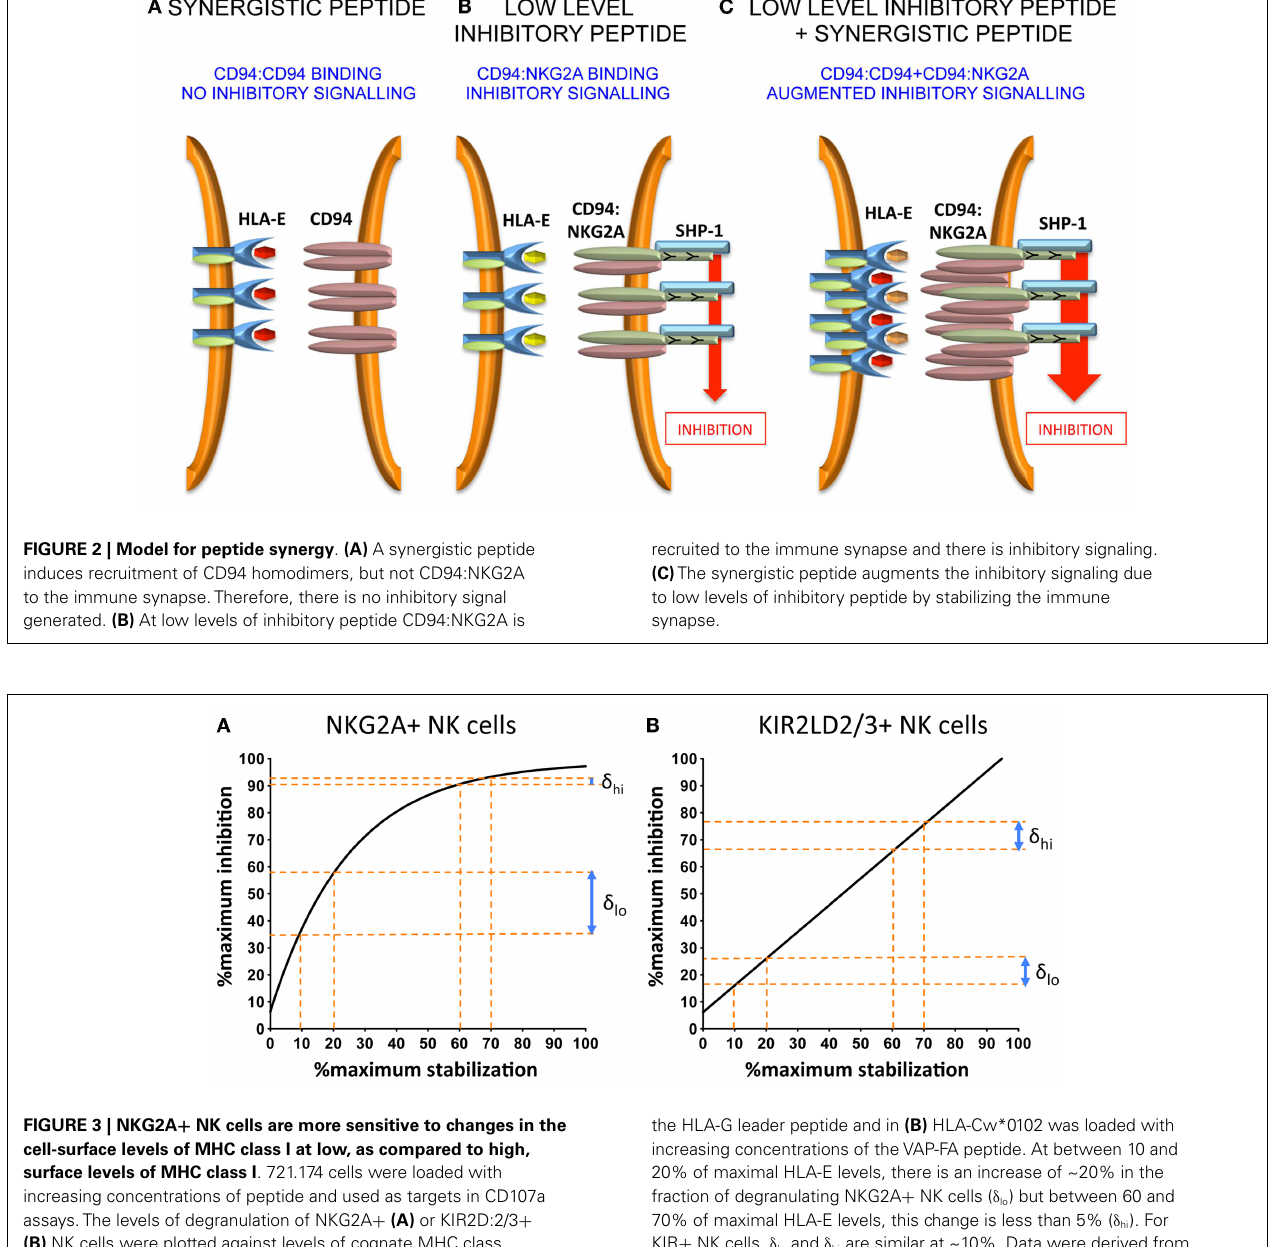
FIGURE 3 | NKG2A + NK cells are more sensitive to changes in the cell-surface levels of MHC class I at low, as compared to high, surface levels of MHC class I . 721.174 cells were loaded with increasing concentrations of peptide and used as targets in CD107a assays.The levels of degranulation of NKG2A + (A) or KIR2D:2/3 + (B) NK cells were plotted against levels of cognate MHC class I:peptide. In (A) HLA-E was loaded with increasing concentrations of